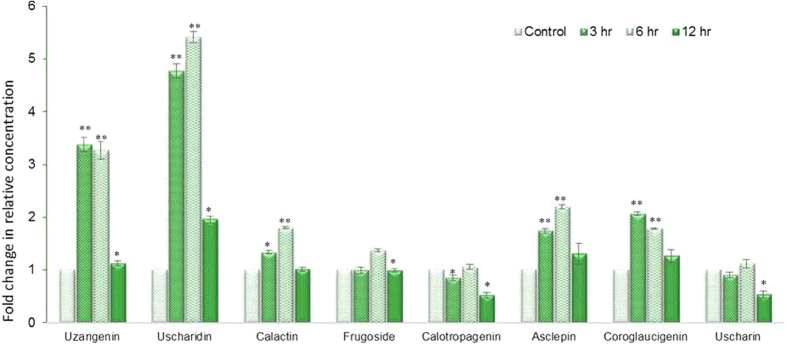
Accumulation of CGs and genin units after 3, 6, 12 hr of wounding in C. procera whole plant measured with LC-MS/MS.Each value is the mean of three replicates, and error bars indicate SDs. Asterisk *(P < 0.05) and **(P < 0.001) indicate significant differences as determined by Student’s t test.